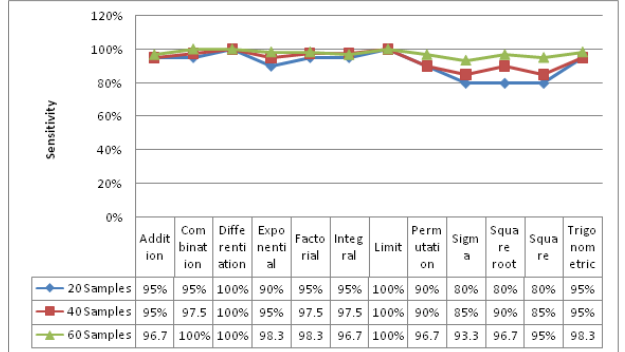
Figure 3 . Overall Sensitivity Measure with Tensorflow from a document.